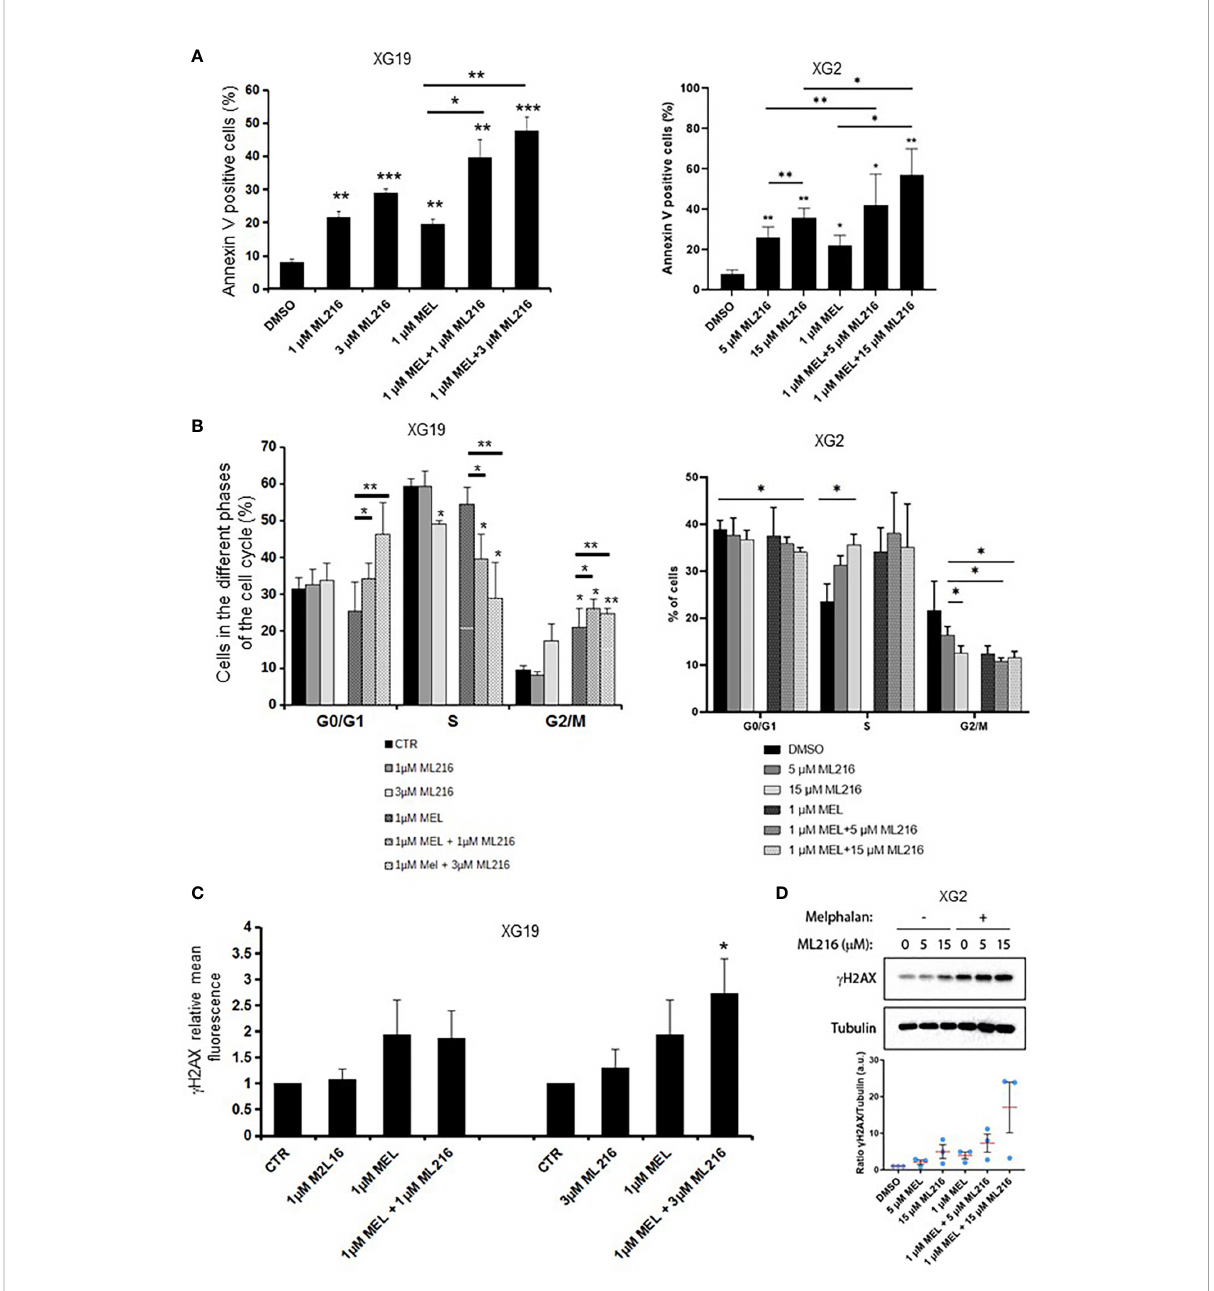
FIGURE 7 Effect of combination of ML216 and melphalan. (A) XG19 and XG2 cells were treated with ML216 and melphalan as indicated for 96 hours. Apoptotic cells were detected as Annexin V+ cells by fl ow cytometry. Results are the average of 3 independent experiments. * indicates a signi fi cant increase in apoptosis compared to DMSO controls using a Student ’ s t-test. (B) XG19 and XG2 cells were treated for 96 hours with the indicated concentrations of ML216 and melphalan. BrdU (10 m g/ml) was added during the last 1.5 hours of treatment. Cells were fi xed and processed to detect BrdU incorporation and total DNA (see Materials and Methods for more details). BrdU+ cells were assigned to S-phase. BrdU- cells were assigned to G0/G1 or G2/M phases based on their DNA content. Asterisks indicate a signi fi cant difference compared to DMSO treated (control) cells after applying a Student ’ s t-test: * p-value < 0.05, ** p-value < 0.01. Results are the mean of 3 independent experiments. (C) XG19 cells treated as in (B) were processed to quantify g H2AX intensity by fl ow cytometry (see Materials and Methods for more details). * indicate a signi fi cant difference compared to DMSO treated (control) cells after applying a Student ’ s t-test for pairs: p-value < 0.05. (D) XG2 cells were treated with the indicated doses of ML216 and 1 m M melphalan for 48 hours. Cells were harvested and g H2AX levels were analyzed by western blot. One representative experiment out of three is shown. The graph shows the quanti fi cation of the g H2AX signal (a.u.: arbitrary units) with respect to tubulin, normalized to the control condition (DMSO) in 3 independent experiments. *** p-value <